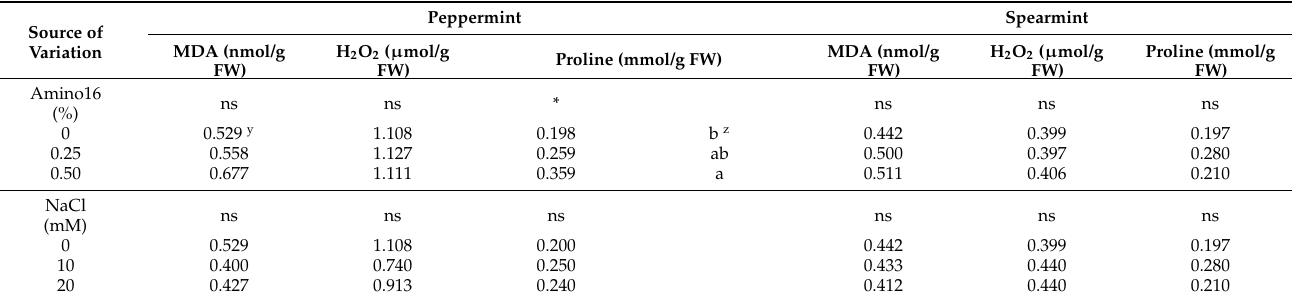
Table 3. Malondeladehyde, hydron peroxide and proline content of peppermint and spearmint plants grown hydroponically in a floating system on a nutrient solution supplemented either with 0, 0.25 or 0.50% of a commercial amino acid solution (Amino16 ® , EVYP LLP) or 0, 10 and 20 mM